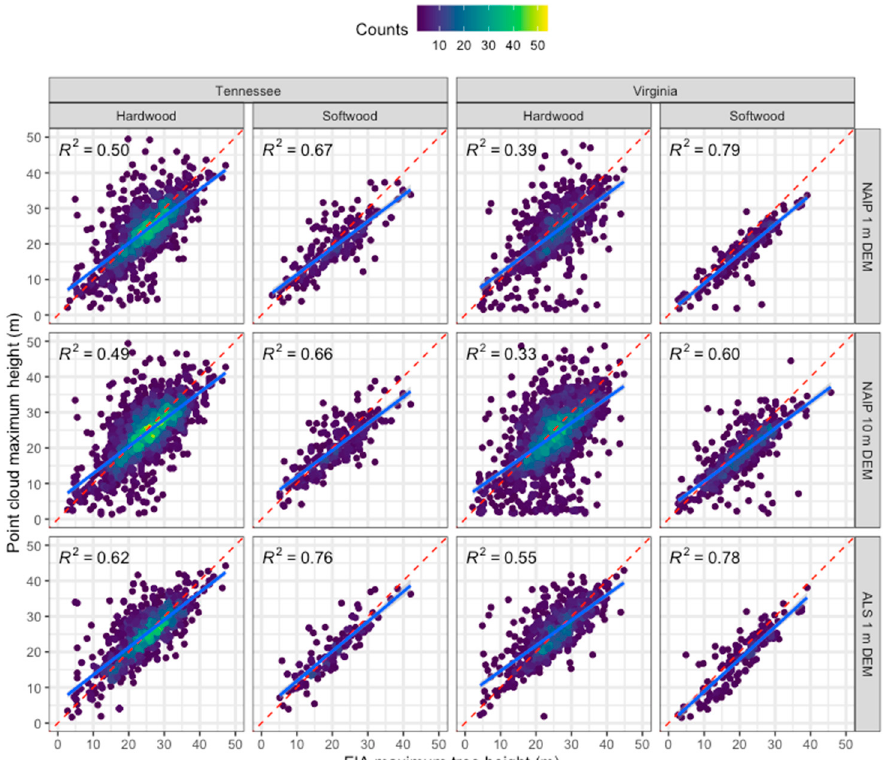
Figure 4. Scatter plot of FIA maximum tree heights (x-axis) vs. maximum point cloud heights (y-axis). Columns are broken out by state and species group (i.e., hardwood and softwood), while rows show the point cloud heights obtained for NAIP and ALS using different DEM resolutions. Plots are shaded from blue (low) to yellow (high) to indicate the density of observations that occur in places where multiple plots overlap. Blue lines are the reduced major axis regression (RMA) fits and the red dashed lines are the 1:1 lines.